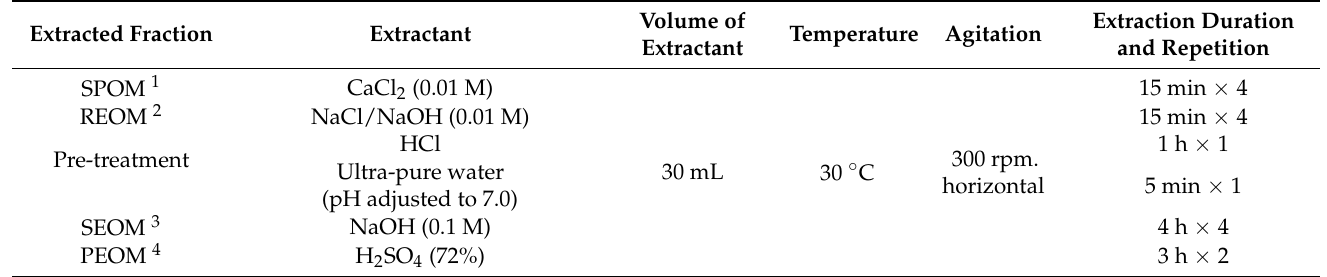
Table 2. Protocol of sequential